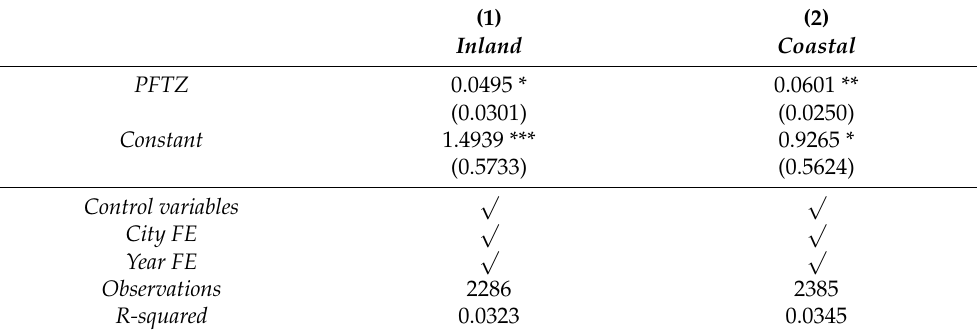
Table 9. The inland and the coastal